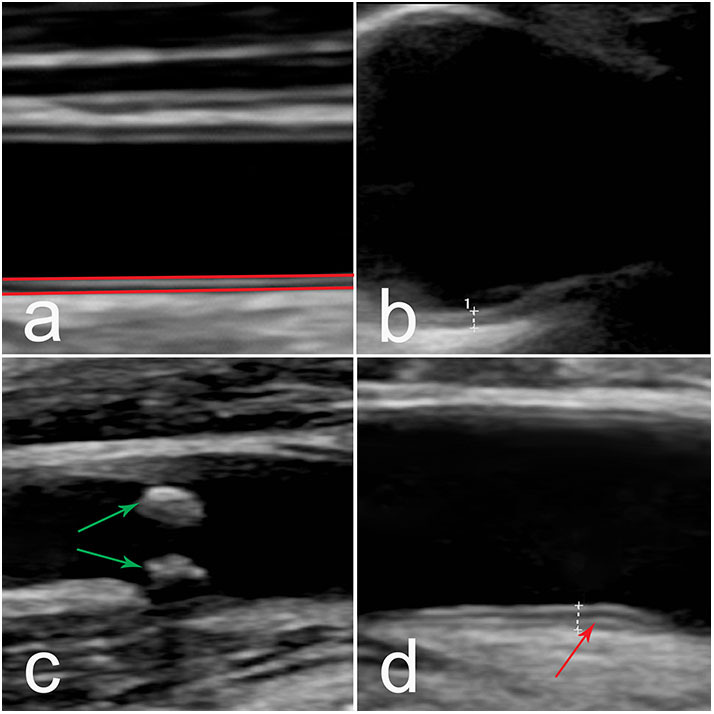
(a) Ultrasound image of the CCA. Principle of IMT measurements (red lines) in the vessel. (b–d) Ultrasound images of different vessel wall appearance, (b) smooth medium echogenic, homogenous wall thickening in the aortic arch, (c) atherosclerotic plaque (green arrow) in CCA bifurcation, (d) medium echogenic, homogenous wall thickening with fibrotic stripes (red arrow) in CFA. IMT, intima-media thickness; CCA, common carotid artery; CFA, common femoral artery.